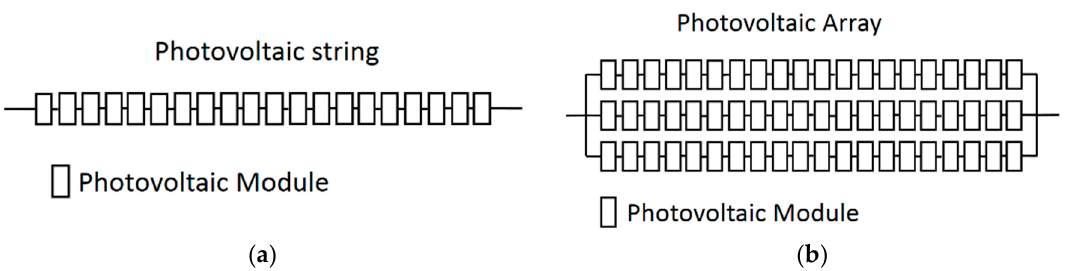
Figure 2. Photovoltaic system: ( a ) Photovoltaic string; ( b ) Photovoltaic array.